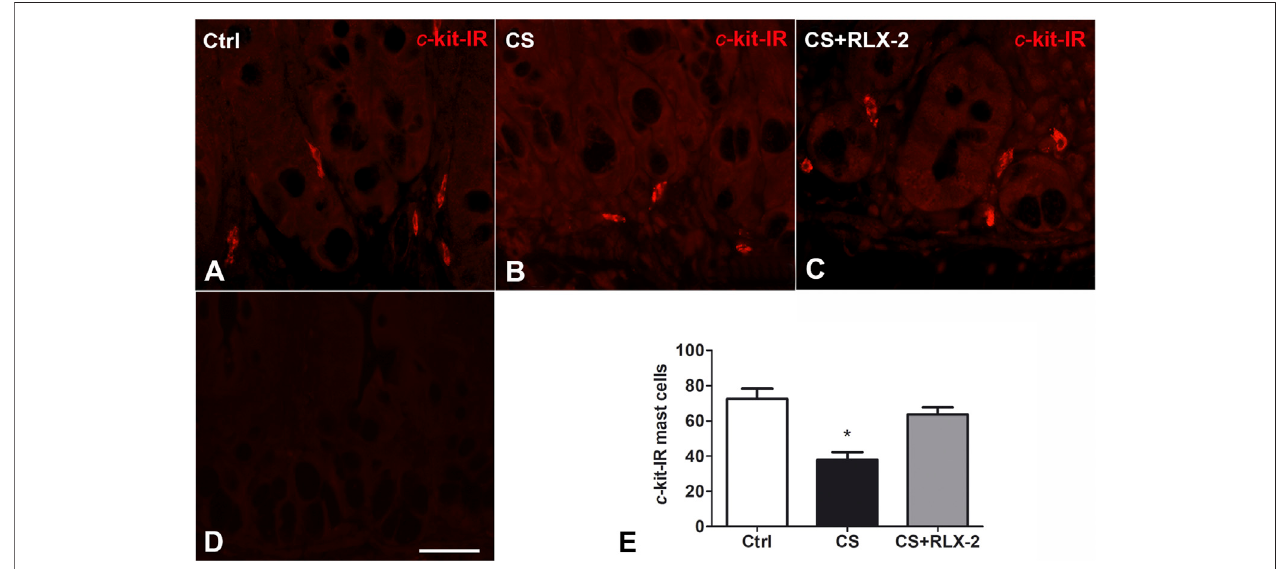
FIGURE 4 | c-Kit-positive mast cells decreased in the cigarette smoke (CS) group. (A – C) Ileum. c -Kit-positive cells corresponding to mast cells are present in the mucosasurroundingtheglandularfundus. (E) Quantitationofthenumberof c -kit-positivemastcellsshowedasigni fi cantdecreaseinCS-exposedanimals. (D) Negative control. This decrease was prevented by relaxin-2 (RLX-2). Bar , 25 μ m (A – D) . * p <